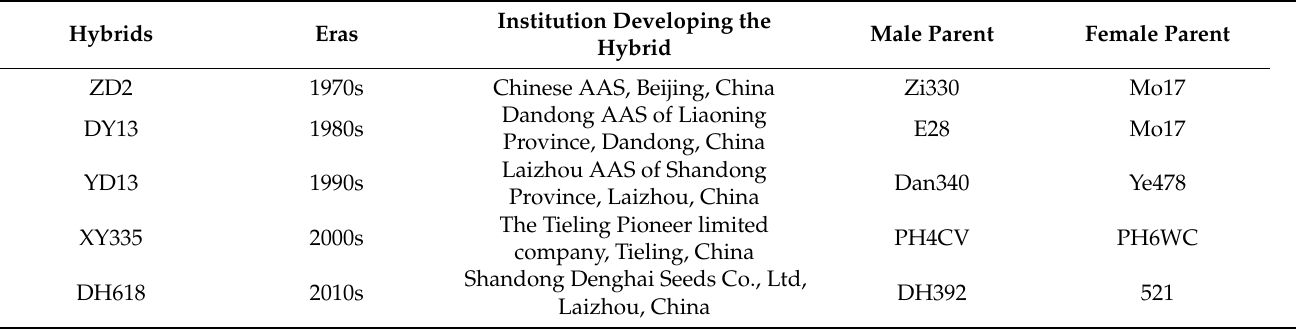
Table 2. Pedigree table of tested